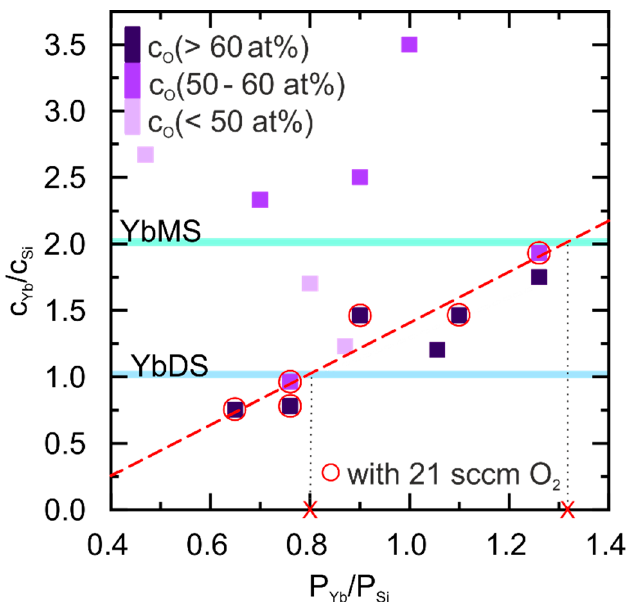
Figure 2. Parameter selection with different oxygen flow rates represented by the cation ratio of Yb and Si (measured by EDS) as a function of the power ratio of Yb and Si. The green line represents the YbMS cation ratio; the blue line represents the YbDS cation ratio. Each run is represented by the square symbol, where the c Yb /c Si ratio was analysed and the oxygen concentration was measured and colour coded. The red circles around the squares represent the parameters with a 21 sccm O 2 flow rate, while all other points were achieved using a 5 sccm to 29 sccm O 2 flow rate. The dotted line is a linear fit of the results using 21 sccm O 2 . The red crosses indicate the right target power ratio for the YbDS and YbMS coating.